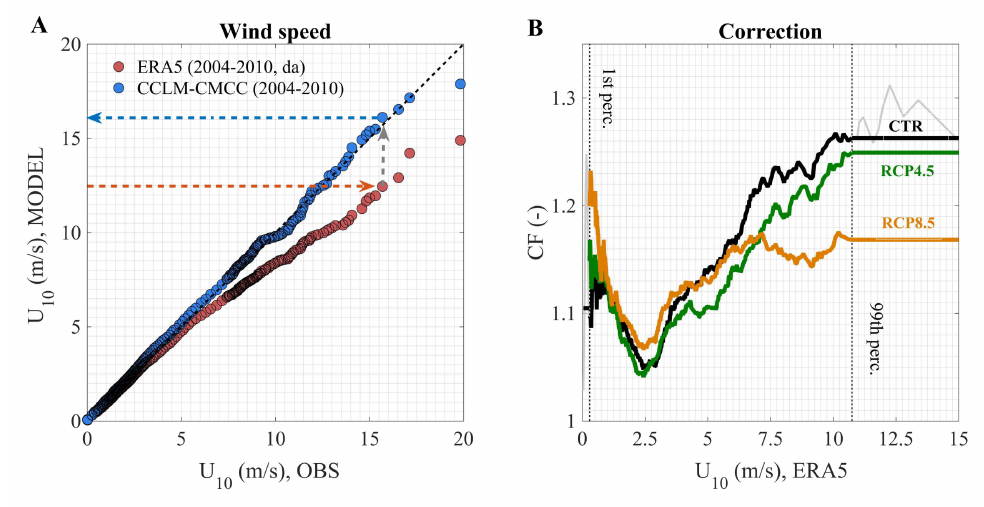
Figure 3. Example of QQM between ERA5 and CCLM-CMCC. ( A ) Quantile-Quantile plot of ERA5 (daily average, da; red markers) and CCLM-CMCC (blue markers) wind speed data ( U 10 , in m/s) against observations (OBS) at the Acqua Alta oceanographic platform (AA) for the years 2004–2010. The two blue and red arrows point to an example of model values at the same quantile that are matched (gray arrow). The dashed black line indicates the perfect 1:1 match between datasets. ( B ) Dependence of the correction factor CF on the ERA5 wind speed for the years 1981–2010 (CTR, black line) and 2021–2050 (RCP4.5, green line; RCP8.5 orange line). The thin, light gray lines show the CTR values below the 1st percentile and above the 99th percentile that are replaced by the nearest value within those two